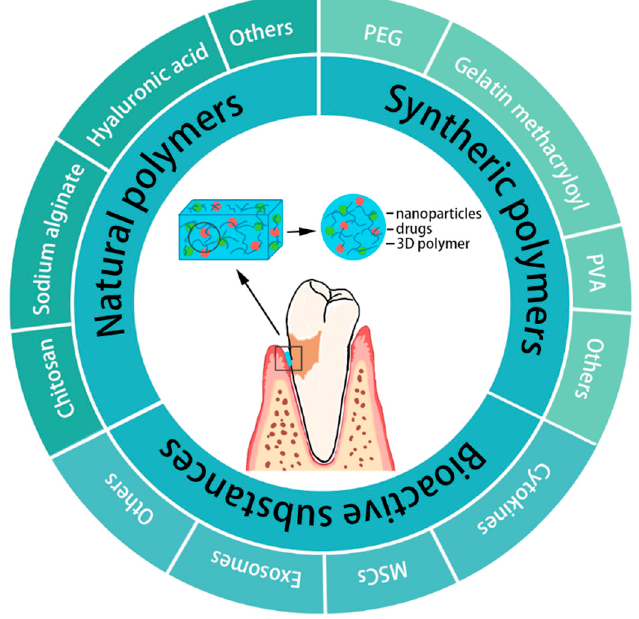
Figure 1. Schematic diagram of the classification of hydrogels in periodontal regeneration.